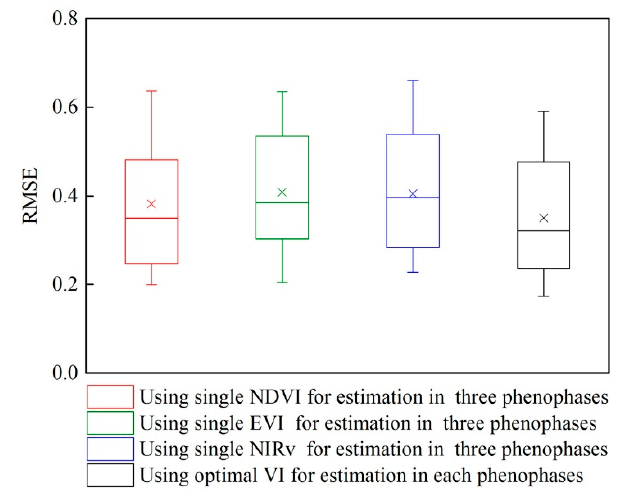
Figure 6. The RMSEs of the LAIs estimated based on the piecewise LAI-VI relationships using a single VI in the three phenophases and those using the optimal VI in each phenophase. See Figure 2 for descriptions of the boxplot.